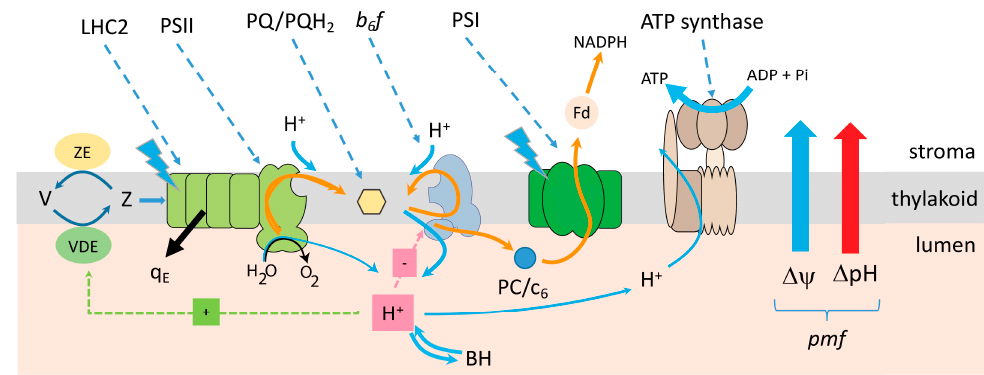
Figure 2. Basic Z-scheme model for the electronic and protonic circuits of the light reactions of photosynthesis, and the pmf paradigm for regulation of the light reactions. Scheme of linear electron flow (LEF) in oxygenic photosynthesis, in which light energy is captured by light harvesting complexes associated with photosystem II (PSII) and photosystem I (PSI), which initiates electron flow (orange arrows) from PSII, through the cytochrome b 6 f complex, plastocyanin (PC), to PSI and ferredoxin (Fd) and finally to NADPH. Also shown is the formation of the LEF is coupled to proton flow (blue arrows) at PSII and the cytochrome b 6 f complex, storing energy in the thylakoid proton motive force ( pmf ). Transfer of electrons from the lumenal to the stromal side of the thylakoid forms a transmembrane electric field ( ∆ ψ , blue arrow), while proton uptake from the stroma and deposition in the lumen lead to the formation of a transthylakoid pH gradient ( ∆ pH, red arrow), which together drive the synthesis of ATP from ADP + P i at the thylakoid ATP synthase, storing energy in ∆ GATP. The acidification of the lumen (indicated by the H + in the red box) activates violaxanthin deepoxidase (VDE) which converts violaxanthin (V) to zeaxanthin (Z) and protonates the PsbS protein, which triggers the photoprotective dissipation of light energy by the q E (black arrow). Lumen pH also regulates electron flow (red box with ‘-‘) to PSI by slowing the rate of PQH 2 oxidation at the cytochrome b 6 f complex.